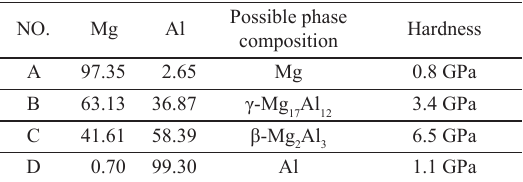
Figure 6. EDS line scan (a) and (b) point scan results of the IMC reaction Table 3. Chemical compositions and hardness of the typical phases in the weld metal (at. %).